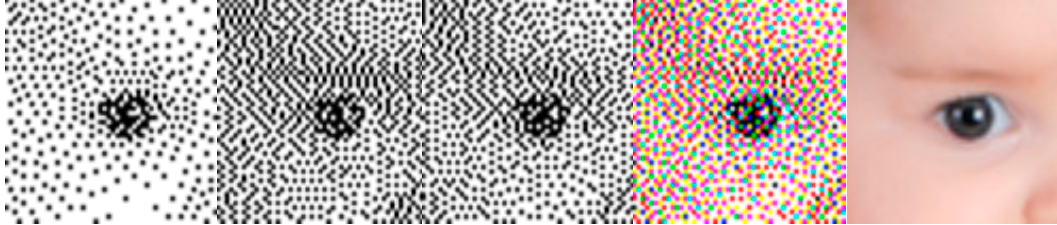
Figure 2. Sample graph showing continuous-tone image, amplitude-modulated (AM) screening image, and frequency-modulated (FM) screening image from left to right. Figure 3. Color halftoning process. R, G, and B channels of RGB image; color halftone image; and continuous-tone image are shown from left to right in that order.